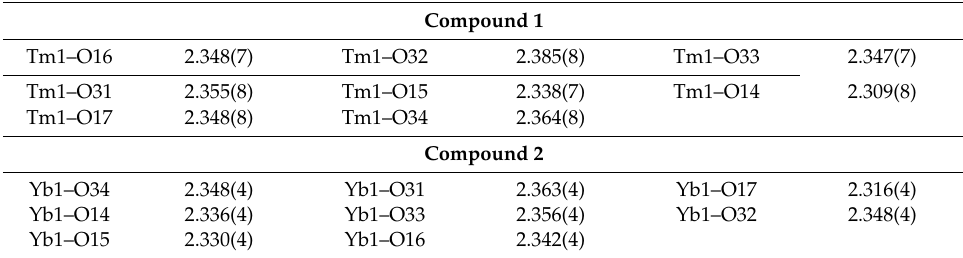
Table 2. Selected bond lengths of 1 and 2 (Å).